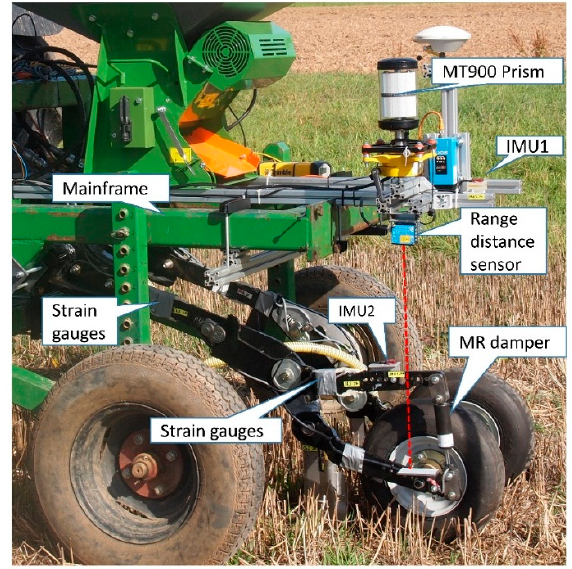
Figure 1. The developed prototype with the coulter assembly and the utilized sensors for capturing its dynamics.